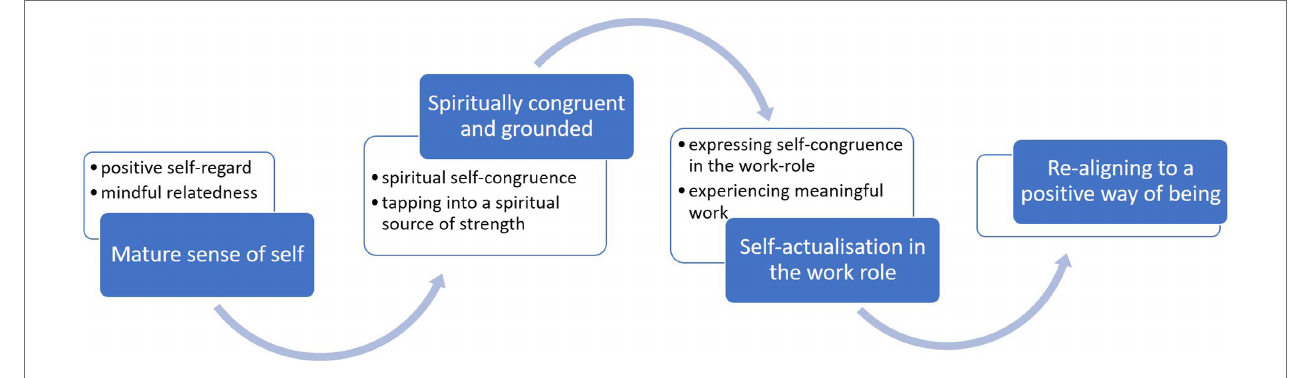
FIGURE 1 | Themes describing the experience of authenticity as